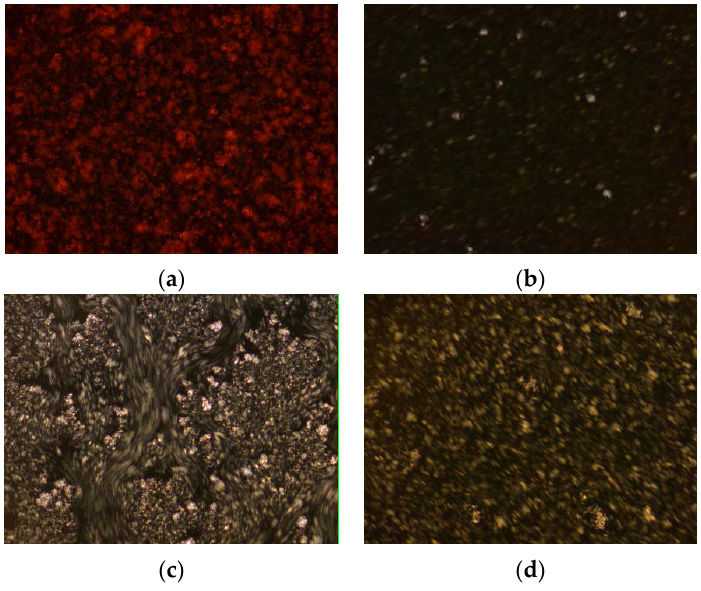
Figure 8. Effect of drag-reducing surfactant addition on the agglomeration structure of wax crystals: ( a ) initial waxy crude oil at 35 °C; ( b ) adding biobased surfactant of 50 mg/L at 35 °C; ( c ) adding biobased surfactant of 100 mg/L at 32 °C; ( d ) adding biobased surfactant of 100 mg/L at 30 °C.